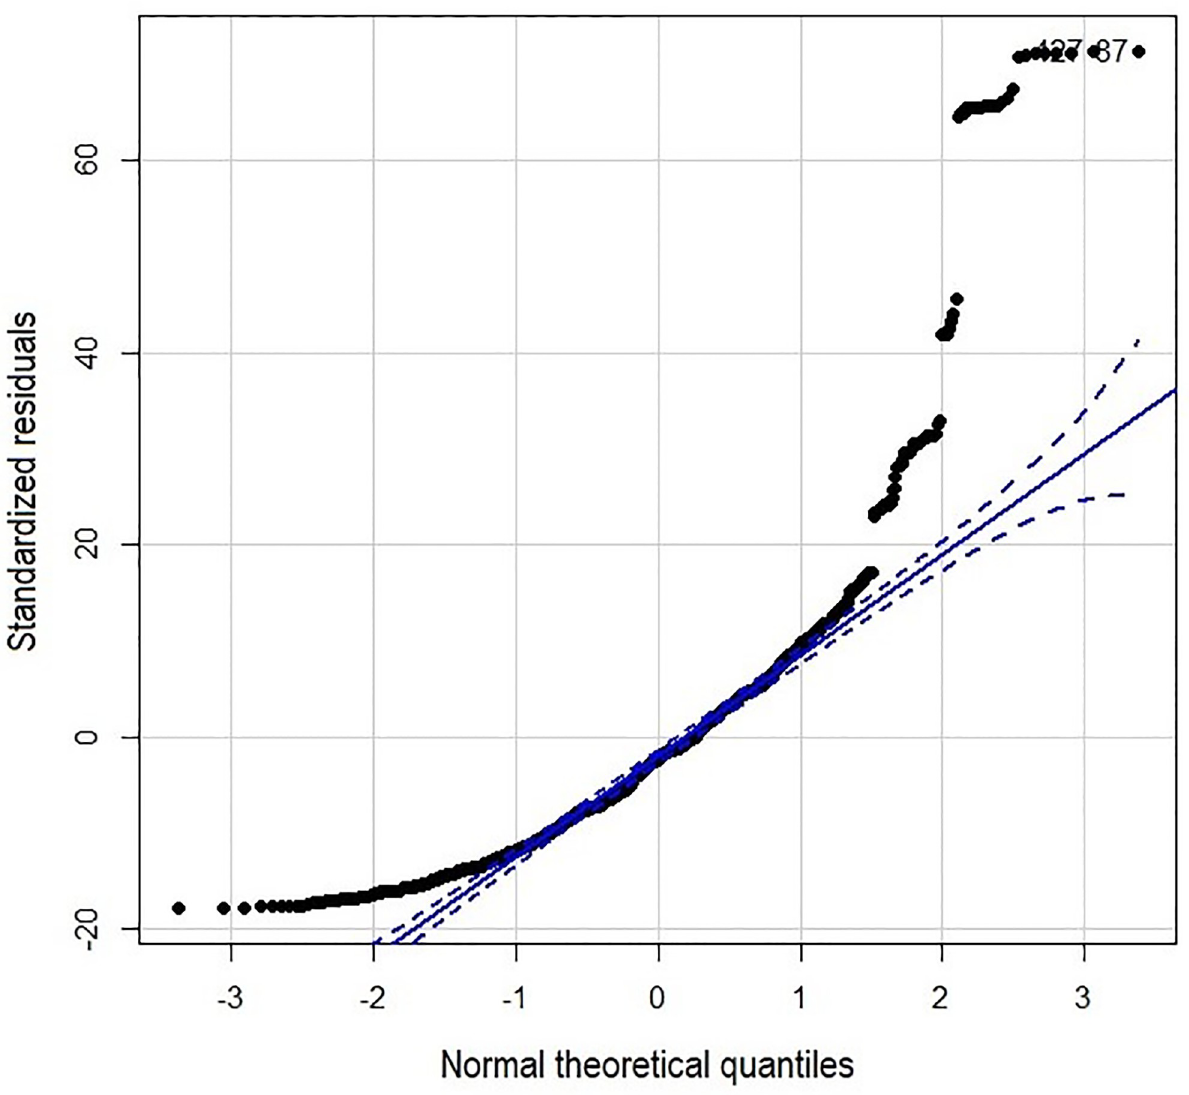
Fig 4. The standardized residuals compared to the normal distribution in a quantile-quantile plot. The distribution of the points is curved at the extremes, suggesting a higher loading of the residual values there, being more noticeable at the right end.